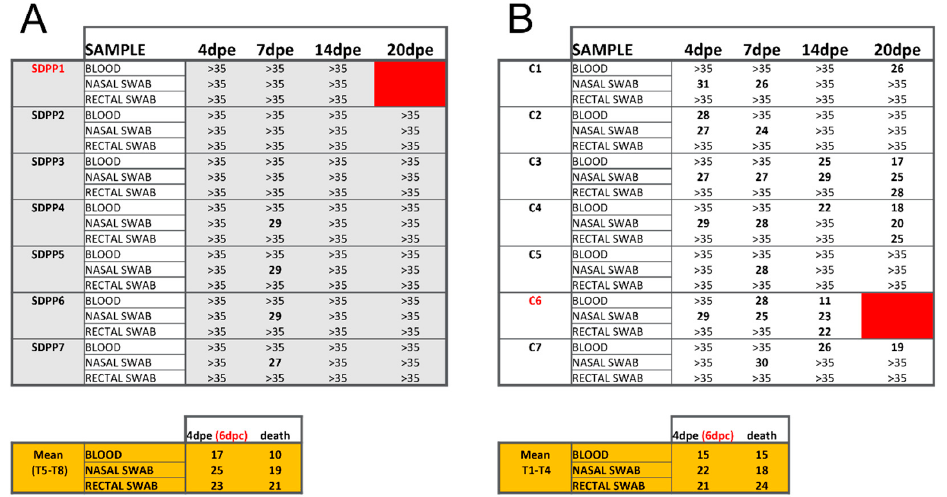
Figure 3. Ct values obtained by qPCR using blood, nasal and rectal swabs from individual animals at different times post-Georgia 2007/01 exposure (pe). Data from pigs fed ( A ) the SDPP diet (SDPP1-7 pigs) or ( B ) the conventional diet (C1–C7 pigs). The higher the Ct values, the lower the ASFV load, with Ct values > 35 being considered negative (cut-off of the technique). Tables in orange show the average Ct values obtained in samples from Trojan pigs. Animals in red color died before the end of the experiment.